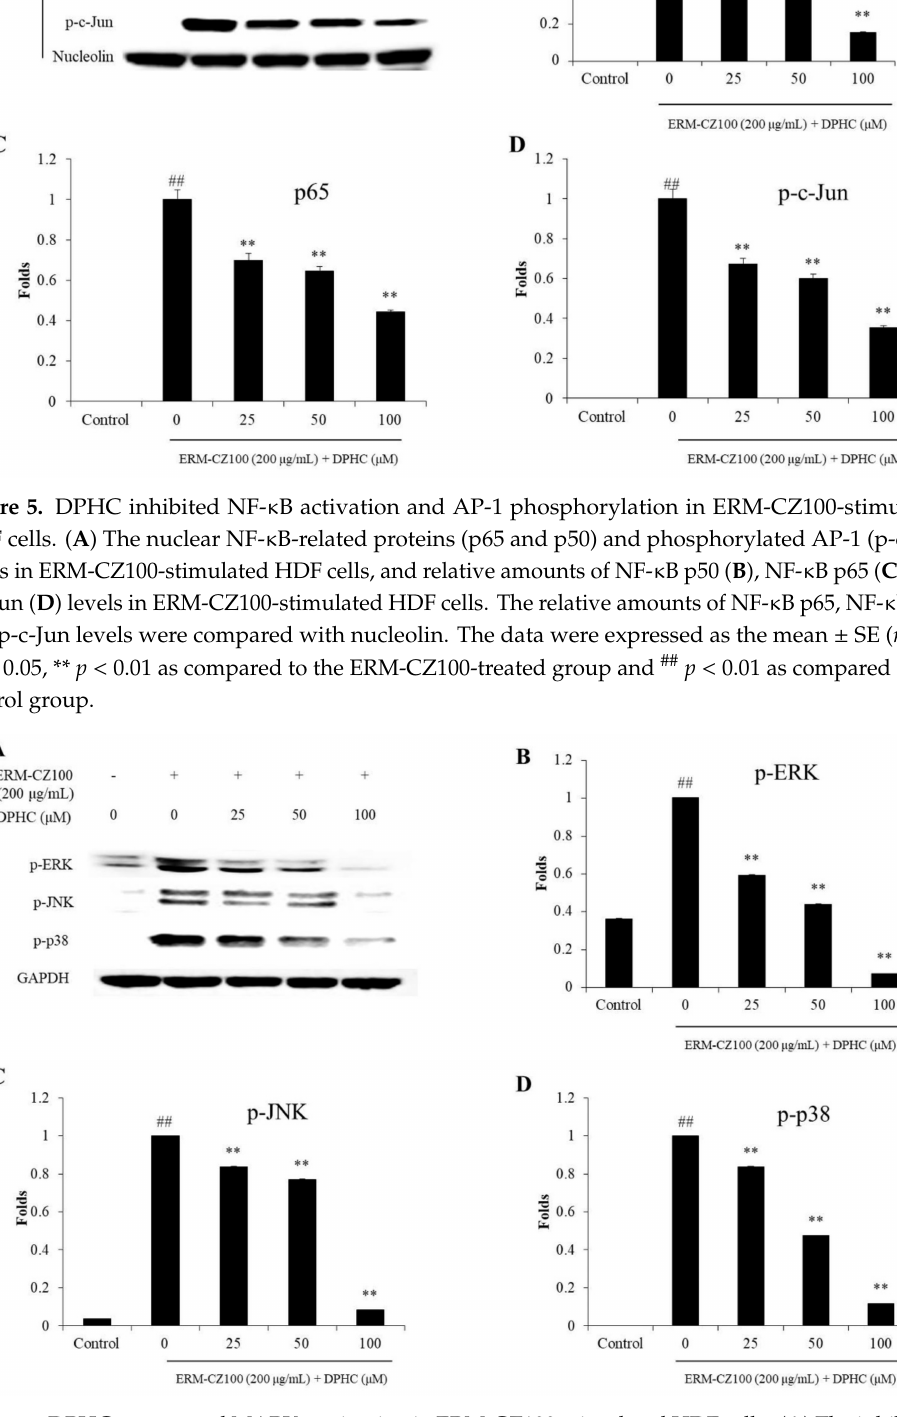
Figure 6. DPHC suppressed MAPKs activation in ERM-CZ100-stimulated HDF cells. ( A ) The inhibitory e ff ects of DPHC on ERM-CZ100-stimulated MAPKs activation in HDF cells, and relative amounts of activated p-ERK ( B ), p-JNK ( C ), and p-p38 ( D ) levels in ERM-CZ100-stimulated HDF cells. The